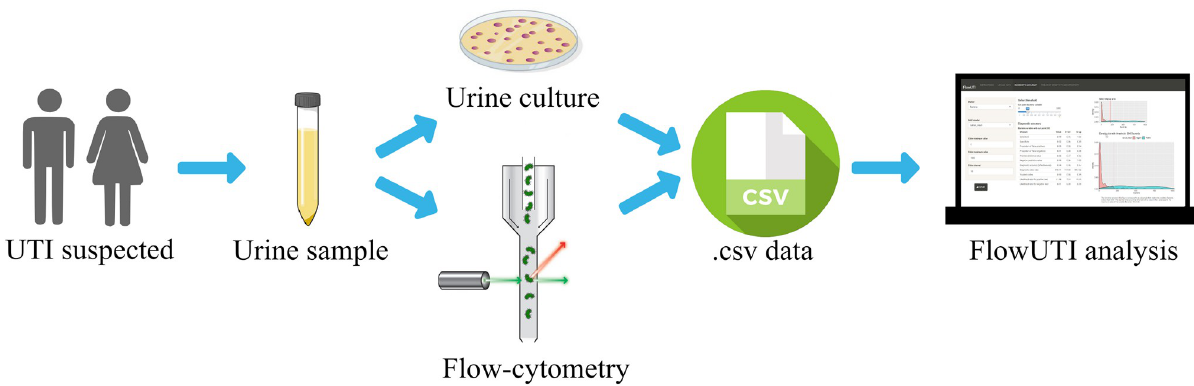
Fig 1. FlowUTI workflow. Flow cytometry figure was adapted from www.cytognos.com, and csv figure from www.shareicon.net.